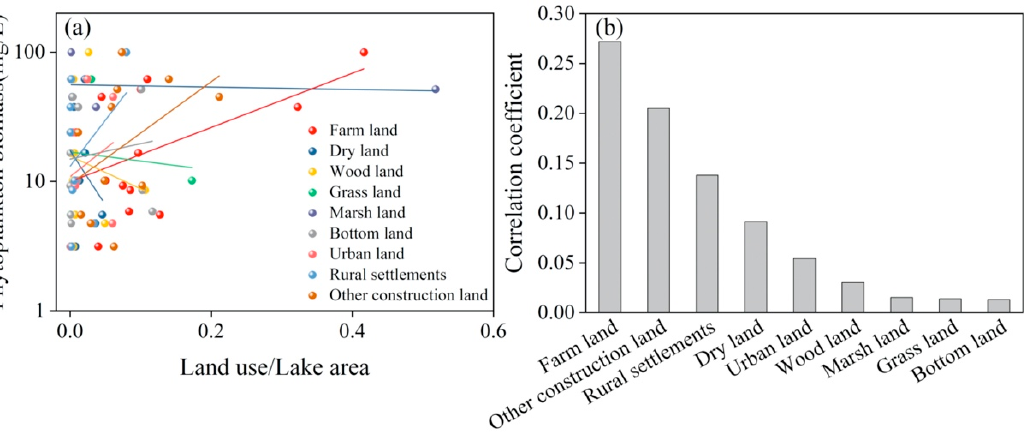
Figure 5. Correlations between phytoplankton biomass and drainage ratio values associated with different land use types. ( a ) Correlation analysis; ( b ) Correlation coefficient.